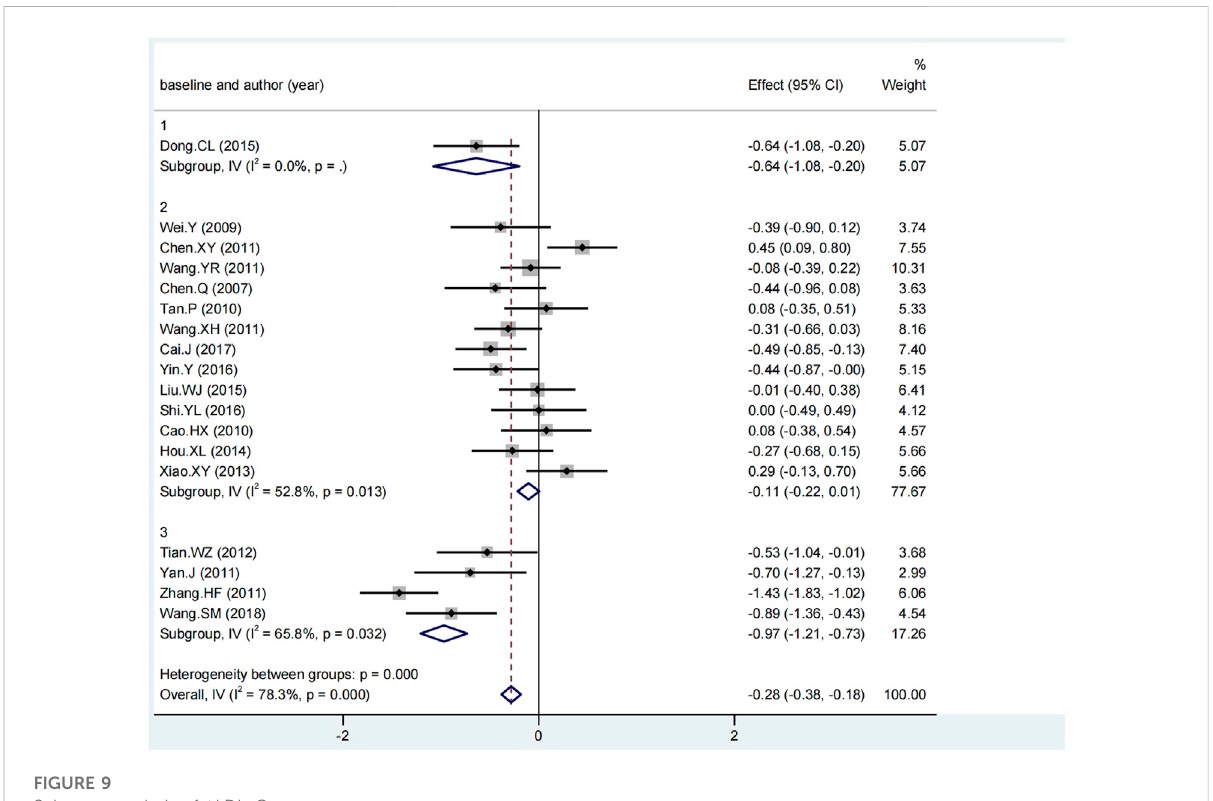
FIGURE 9 Subgroup analysis of Δ